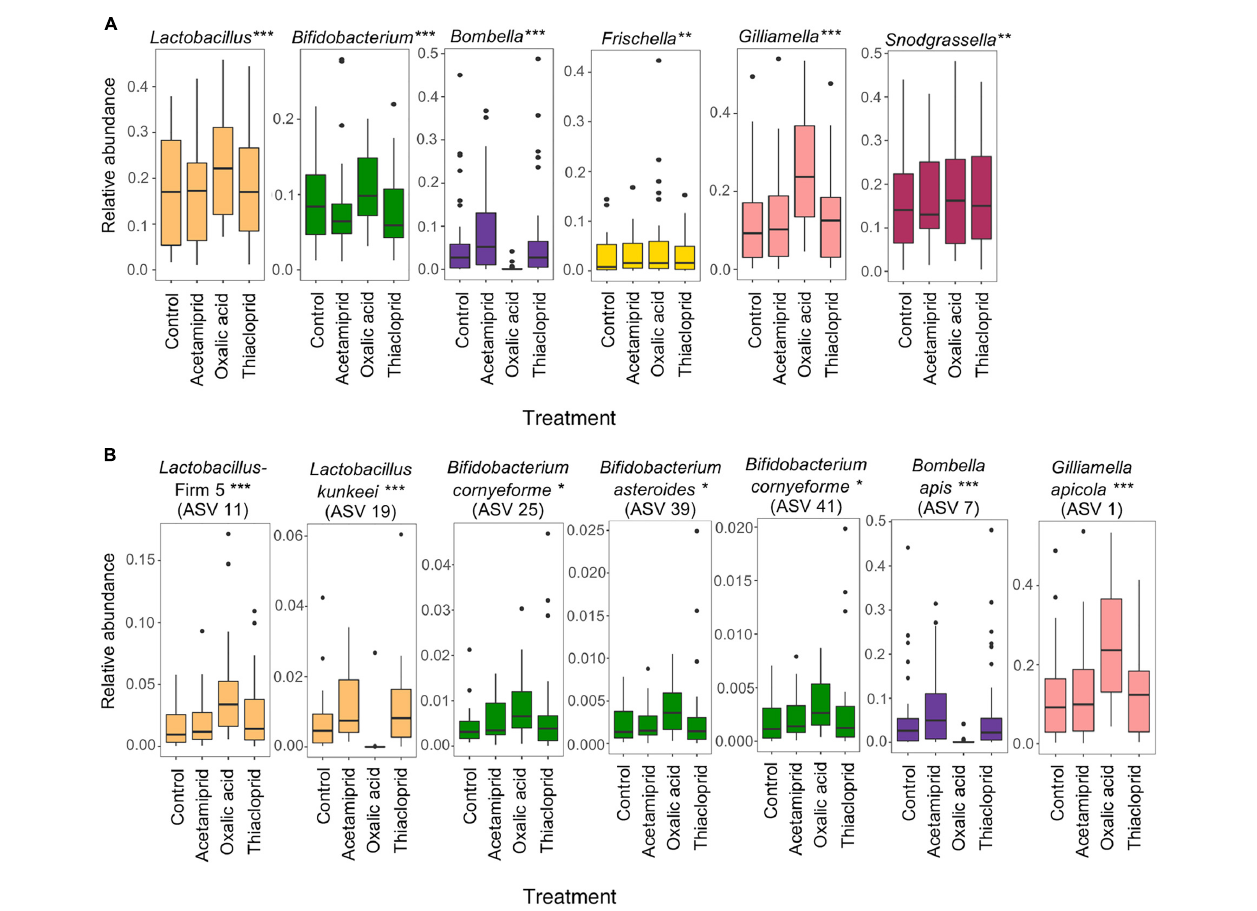
FIGURE 6 | Oxalic acid treatment changes microbial relative abundance in vivo . (A) Relative abundance of core microbes at the genus level between controls and different pesticide treatments. (B) Relative abundance of differentially abundant ASVs between control and pesticide treatments. Asterisks indicate significant changes between control and oxalic acid treatments assessed in two independent ALDEx2 bivariate models with pesticide treatment and colony as fixed effects (* p < 0.05, ** p < 0.01, *** p < 0.001). Acetamiprid and thiacloprid are not significantly different from controls. Boxplots represent the first and third quartiles of the relative abundance, the horizontal line represents the median, whiskers extend 1.5 interquartile ranges and dots represent